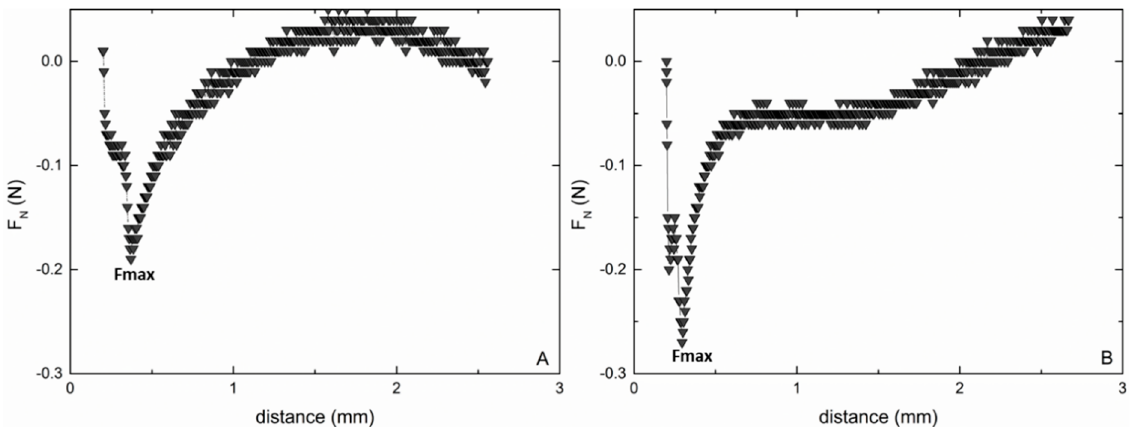
Figure 3. Representative force distance curves for UWS ( A ) and HA 0.25% ( w / w ) ( B ) gained from tack tests.